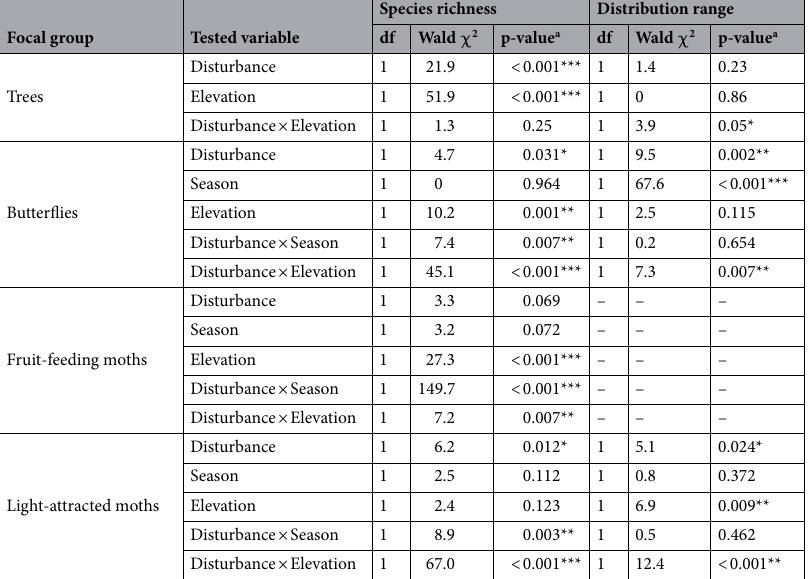
Table 1. Results of the GEE models analyzing effects of disturbance, season and elevation on species richness and mean distribution range of trees and insects in forests disturbed and undisturbed by elephants on